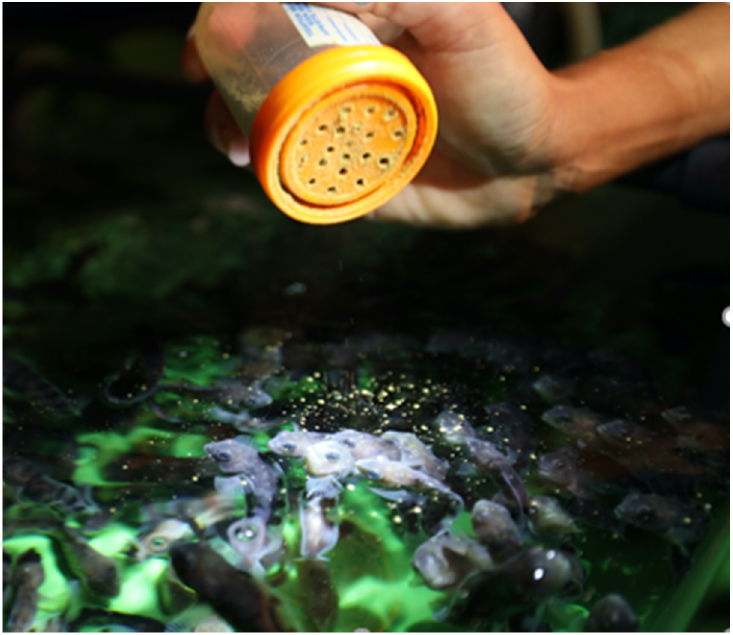
Figure 10. Feeding of juveniles in rearing tank. Source: Merinov, Dupont-Cyr,